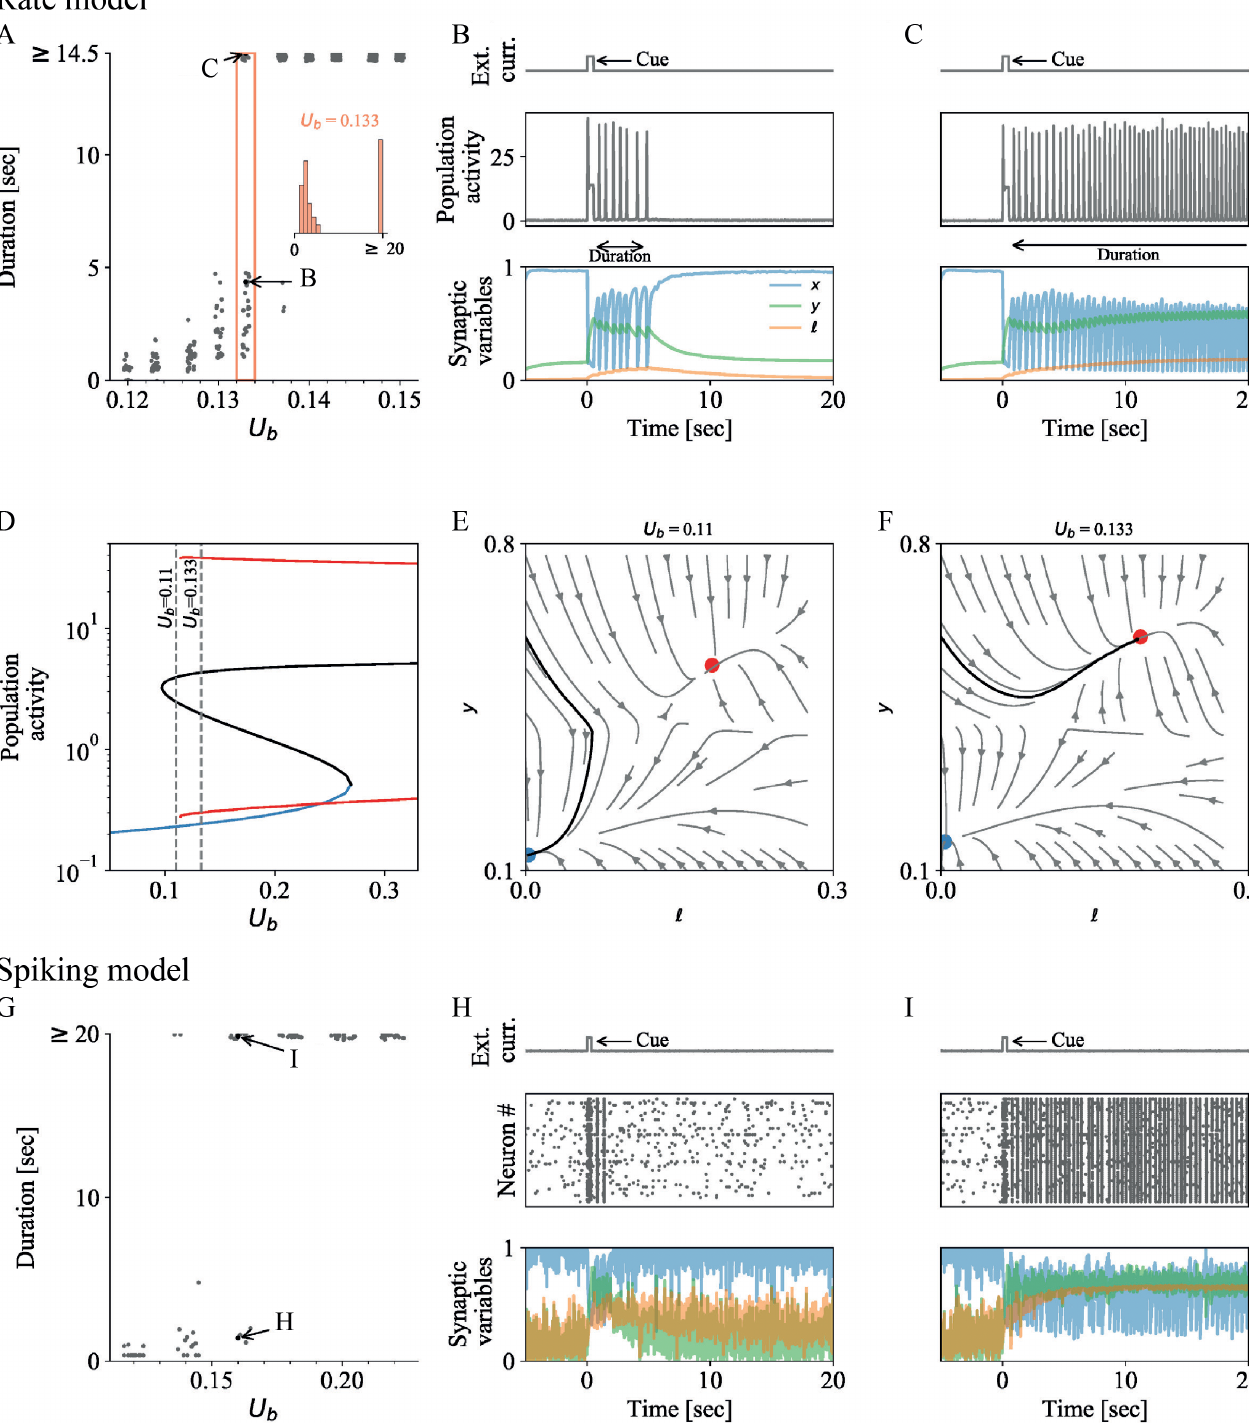
Fig 6. Strong astrocytic signaling introduces bimodal distribution of transient WM durations and ‘window of vulnerability’ for WM termination. A Analysis of the STP+LPA rate model (see Models and methods, Table C in S1 Text). Parameters: M = 0.4, Δ U = 0.4, τ L = 5sec, remaining parameters: Table D in . As the phase transition is crossed, the range of durations of transient population activity S1 Text. A WM durations for 30 simulations at each of 10 values of U b upon cue stimulation increases continuously (a hysteresis effect emerges if the cue is weak, see Fig I in S1 Text). Inset: Distribution of transient WM durations of 100 simulations at U = 0.133. B-C Two simulations at U = 0.133. Panels as in Fig 4. D Bifurcation diagram, showing stable (blue) and unstable (black) fixed b b